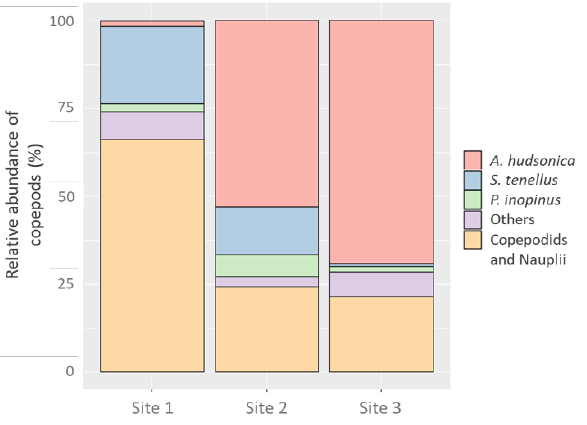
Figure 2. Relative abundance of copepod communities (%) by microscopic